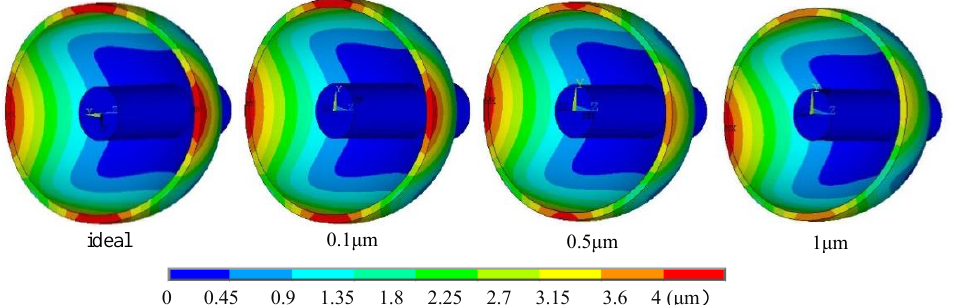
Figure 3. The selected simulation results of resonator deformation caused by the different amplitudes of the first harmonic of uneven capacitance gap.